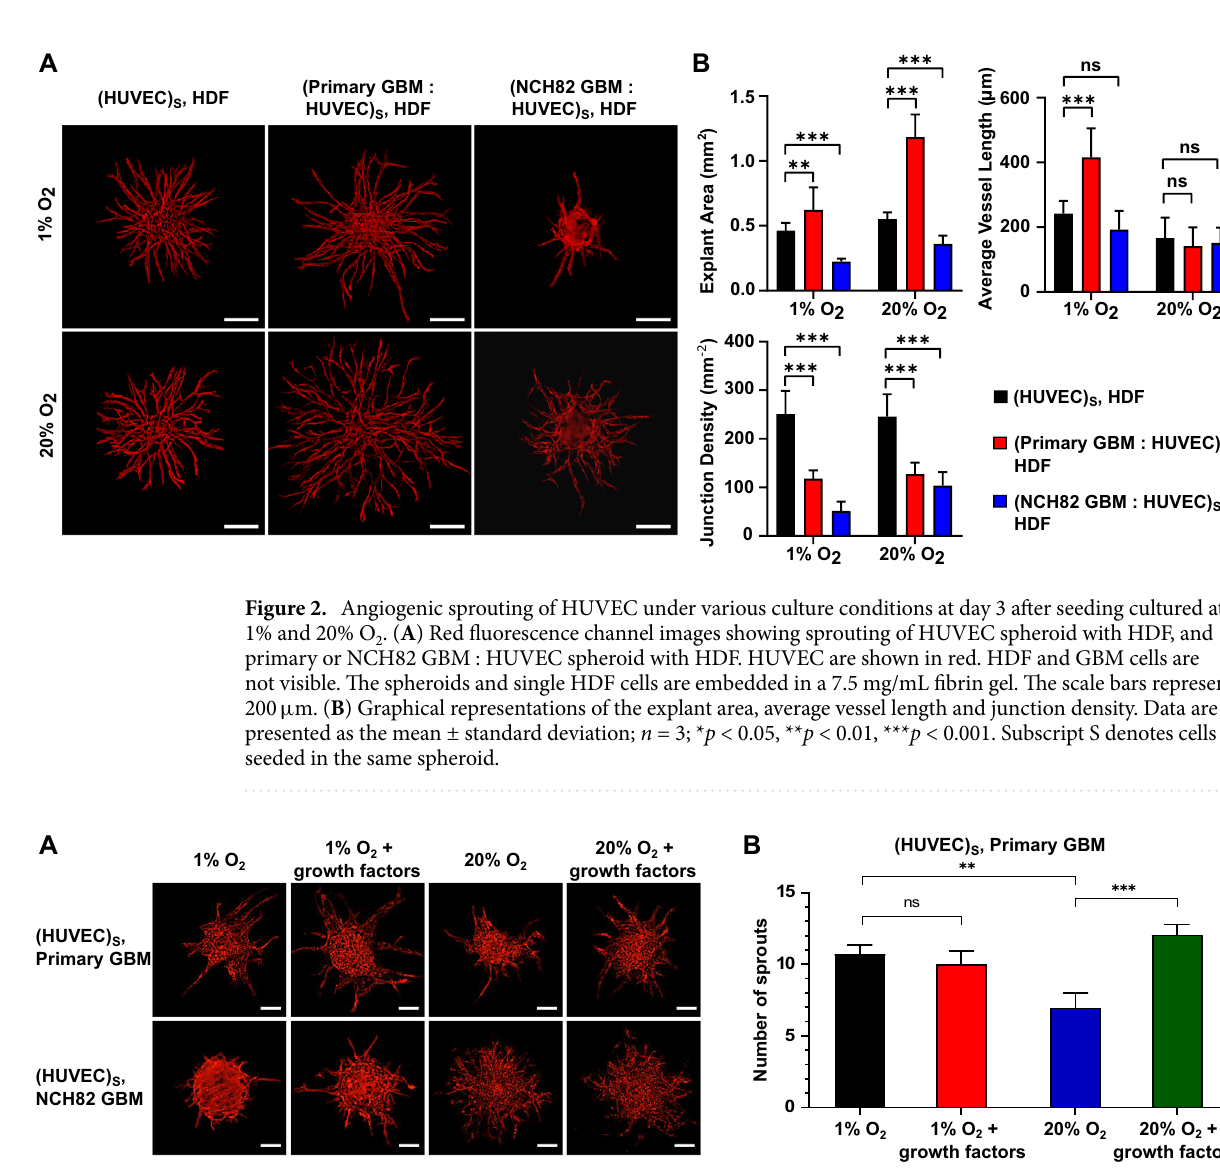
Figure 3. Angiogenic sprouting of HUVEC spheroids with GBM as the supporting cell at 1% and 20% O 2 , with or without additional growth factors. ( A ) Red fluorescence channel images showing HUVEC spheroids with supporting primary or NCH82 GBM cells. Images were taken at day 5 after seeding. HUVEC are shown in red. GBM single cells are not visible. The spheroids and single GBM cells are embedded in a 7.5 mg/mL fibrin gel. The scale bars represent 100 µ m. ( B ) Graphical representation of the number of HUVEC sprouts. Data are presented as the mean ± standard deviation; n = 3; * p < 0.05, ** p < 0.01, *** p < 0.001. Subscript S denotes cells seeded in the same